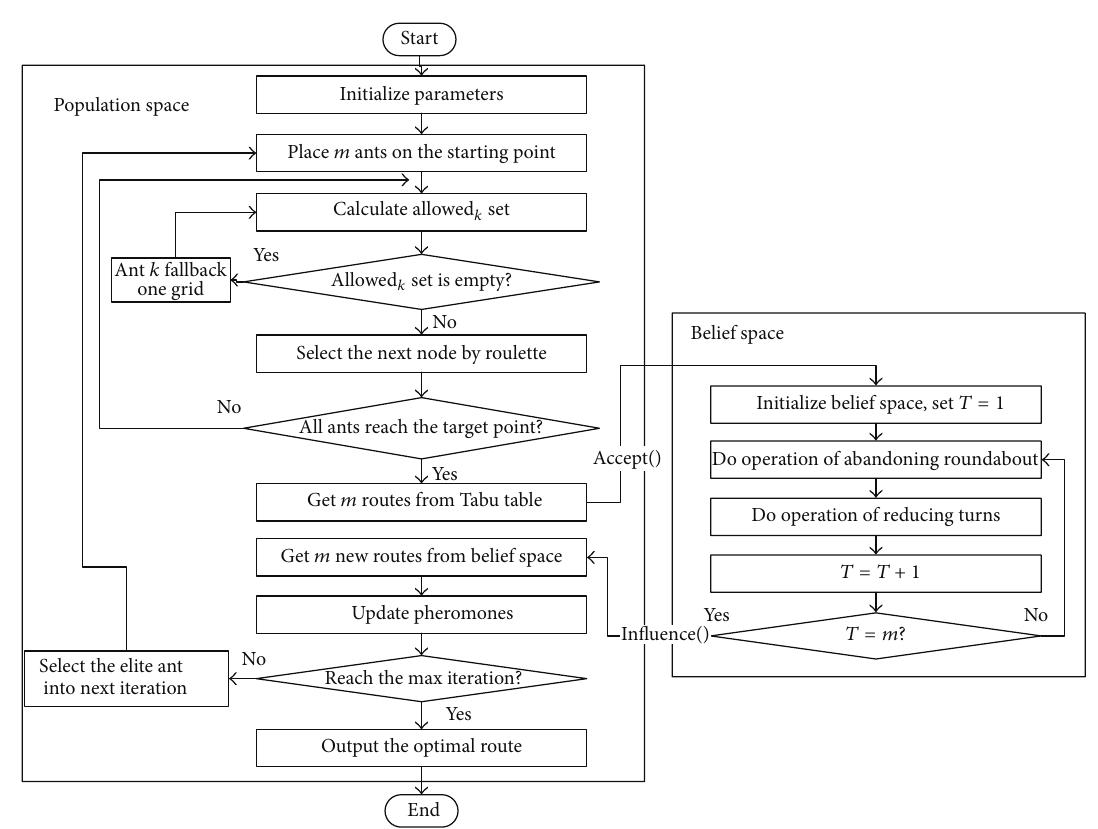
Figure 10: Flow chart of evolutionary ant colony